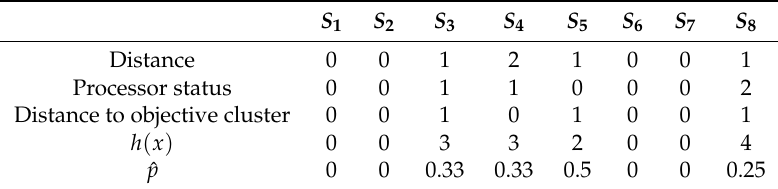
Table 7. Initial population. A second set of evaluation results for each parameter.